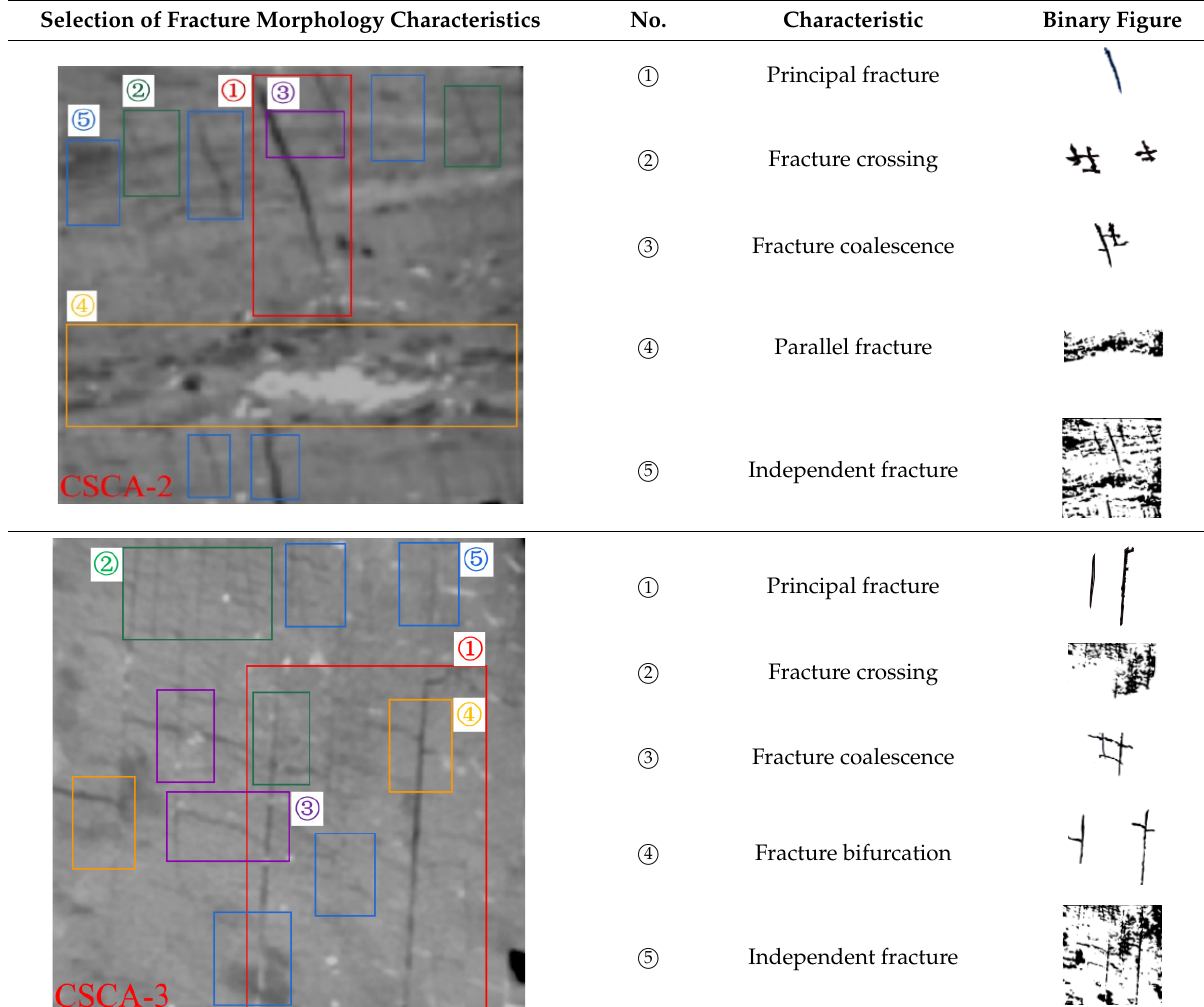
Selection of Fracture Morphology